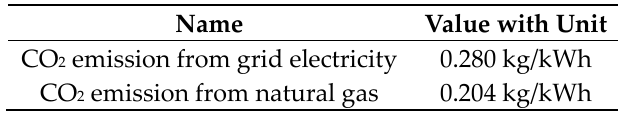
Table 3. Other parameters.